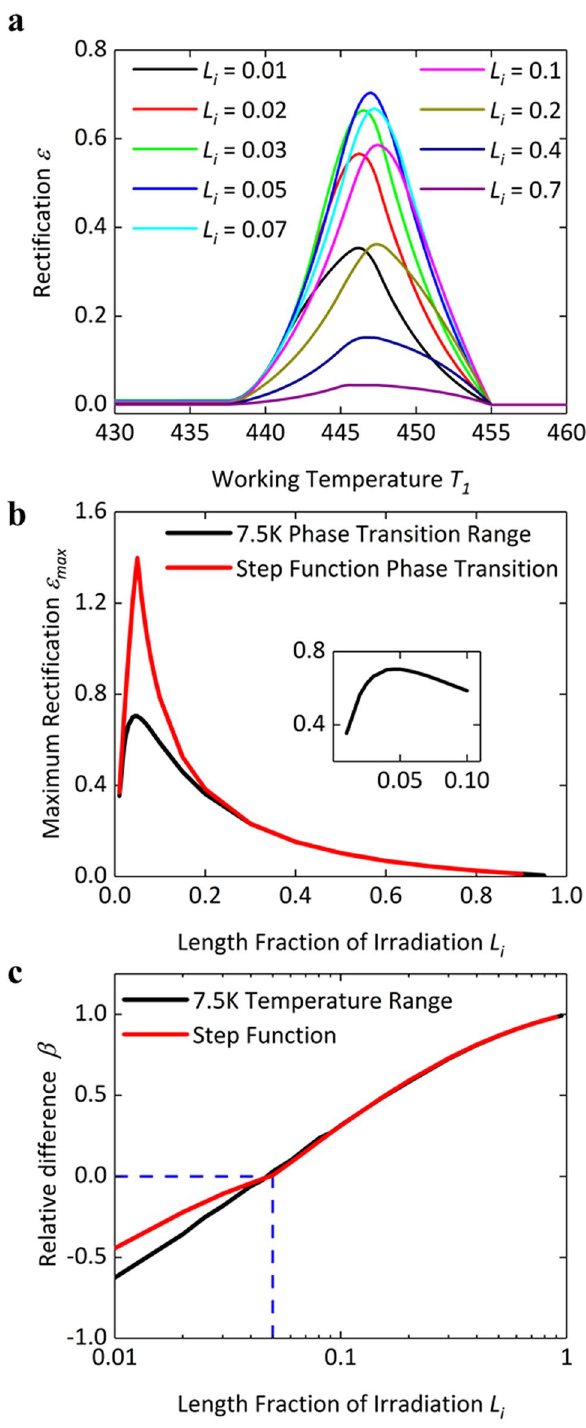
Figure 4. Optimization study of the length fraction of irradiation. ( a ) Rectification as a function of working temperature T 1 with different length fractions of irradiation. ( b ) Maximum rectification ε max as a function of the length fraction with the 7.5 K temperature range and the step function models for phase transition of the pristine segment. The inset figure shows maximum rectification ε max as a function of length fraction within the range of 0–0.1 for the finite-temperature-range model. ( c ) Relative temperature difference β as a function of the length fraction of